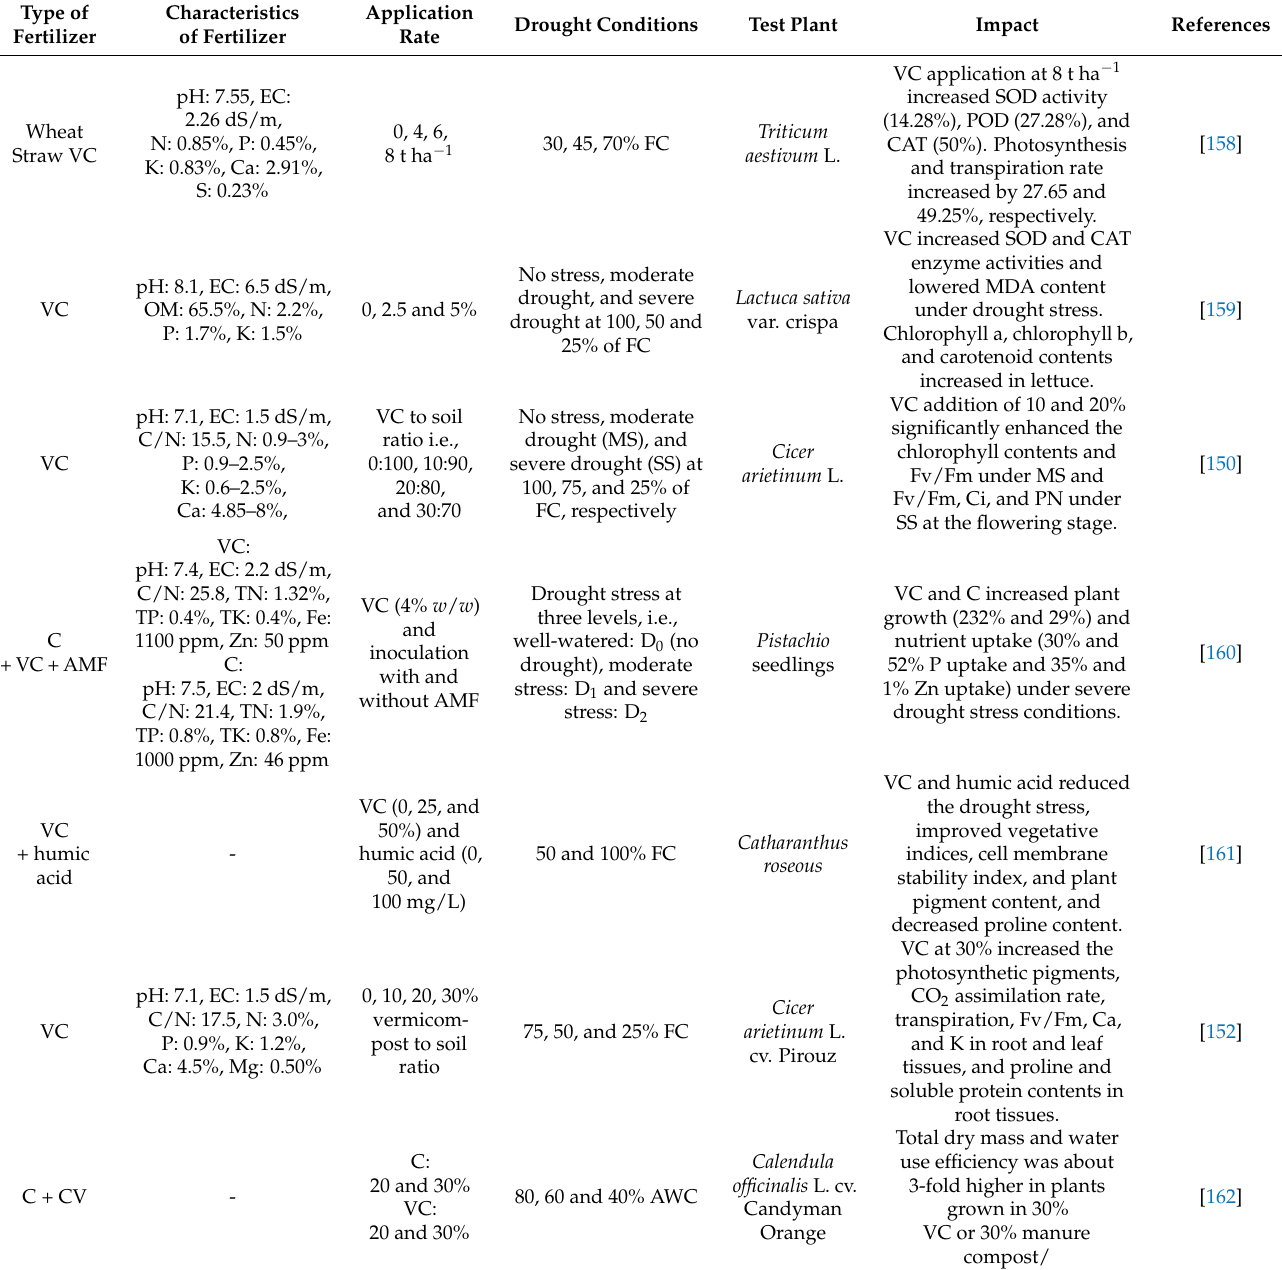
Table 3. Effects of vermicompost alone and in combination with other soil amendments on plant growth performance under drought